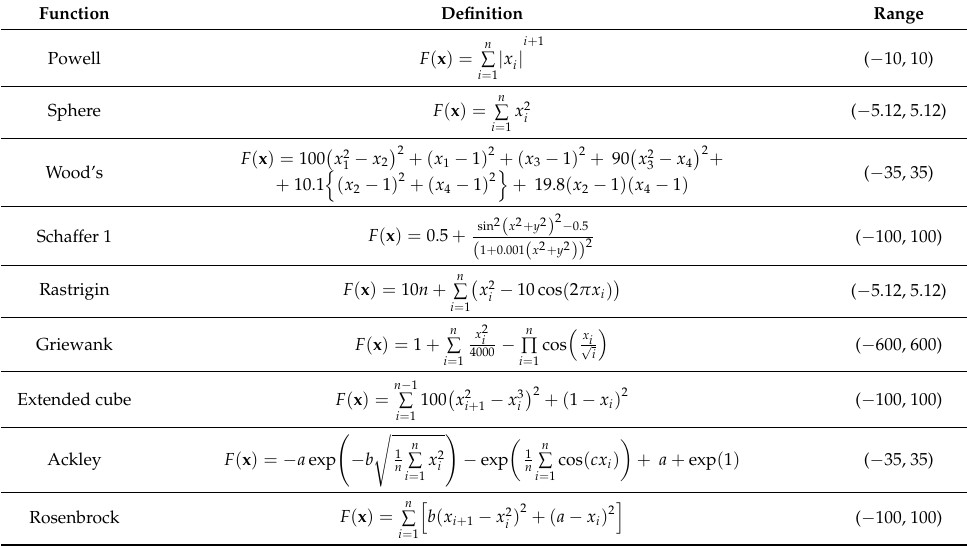
Table 1. Benchmark unconstrained optimization